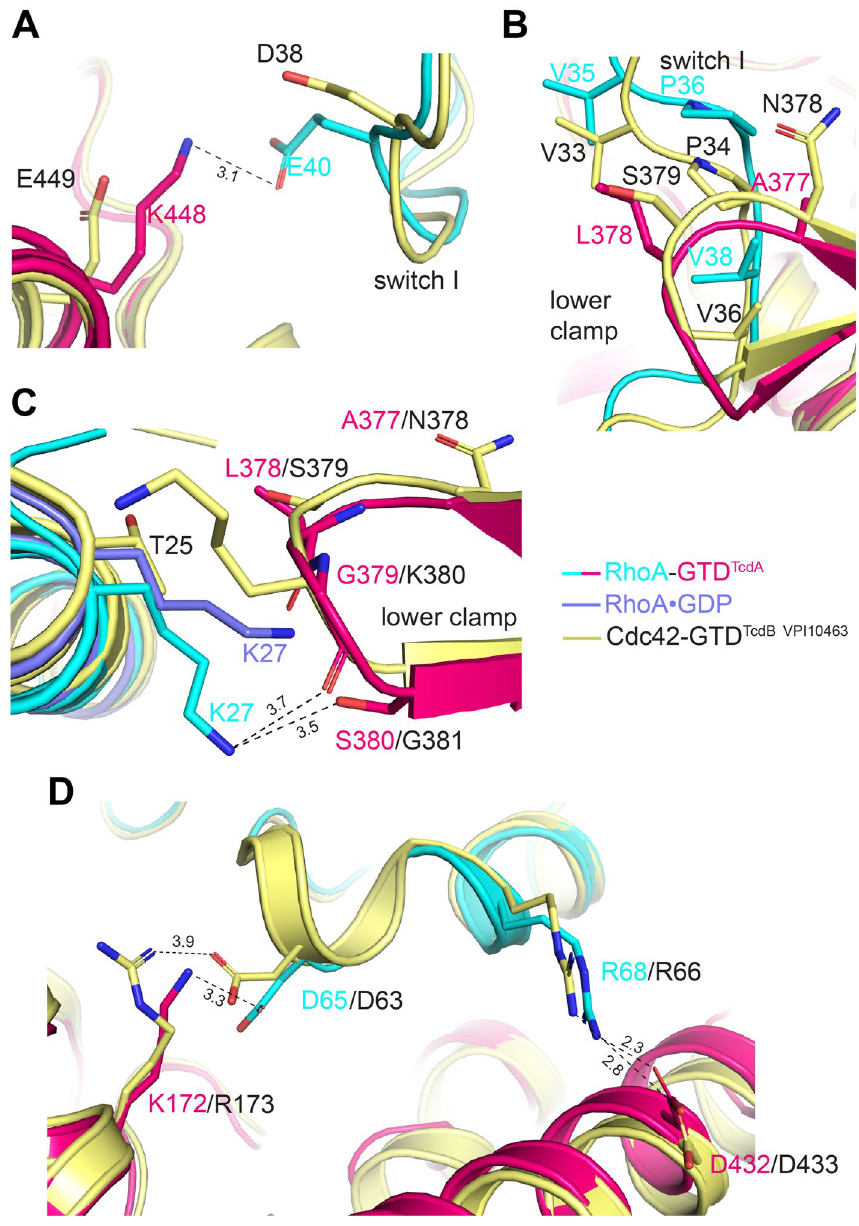
Figure 4. Structural comparison of the GTD TcdA –RhoA and the GTD TcdB-VPI10463 –Cdc42 complexes. ( A ) K448 of GTD TcdA (hot pink) but not the equivalent E449 of GTD TcdB (pale yellow, PDB code: 7S0Y) form a salt bridge with E40 (cyan) of RhoA and potentially D38 of Cdc42 (pale yellow). ( B ) Residues A377 and L378 on the lower clamp of GTD TcdA (hot pink) interact with the switch I of RhoA better than the equivalent N378 and S379 on GTD TcdB-VPI10463 (pale yellow, PDB code: 7S0Y). ( C ) Examining the interactions between the pre-switch I of RhoA (cyan) and the lower clamp of GTD TcdA (hot pink) in the GTD TcdA –RhoA complex when compared to the GTD TcdB-VPI10463 –Cdc42 complex (pale yellow) and RhoA·GDP (slate, PDB code: 1FTN). ( D ) Comparing the interactions in the switch II area for the GTD TcdA –RhoA (hot pink and cyan, respectively) and the GTD TcdB- VPI10463 –Cdc42 (pale yellow)